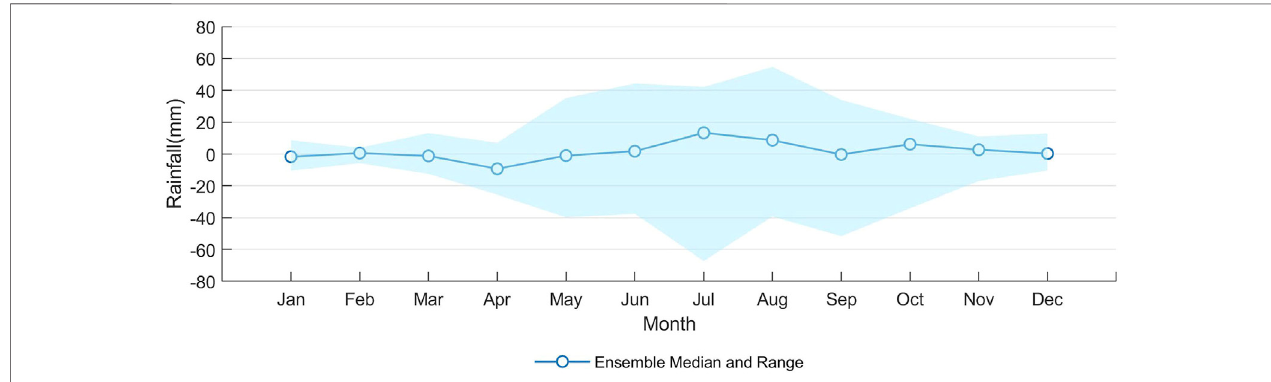
FIGURE4| ProjectedchangesinmonthlyprecipitationcomparedtohistoricalaveragedatainGuangzhouduringthesimulatedperiodforRCP8.5.Note:sourceof information published by the Climate Change Knowledge Portal of the World Bank Group (https://climateknowledgeportal.worldbank.org [accessed 23 Jan 2020]).